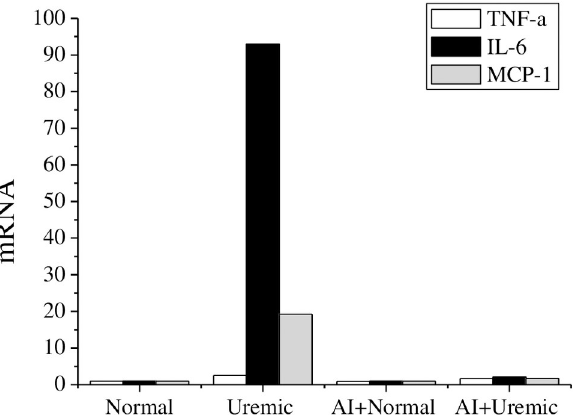
Fig 6. Comparison of M1 marker expression in macrophages of rats in each